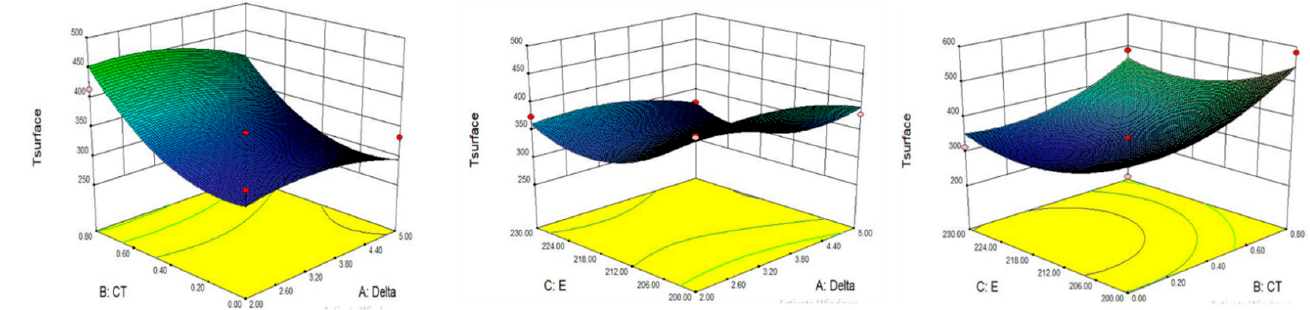
Figure 15. Comparative analysis of maximum surface temperature (response to CT-delta; E-Delta; E-CT).